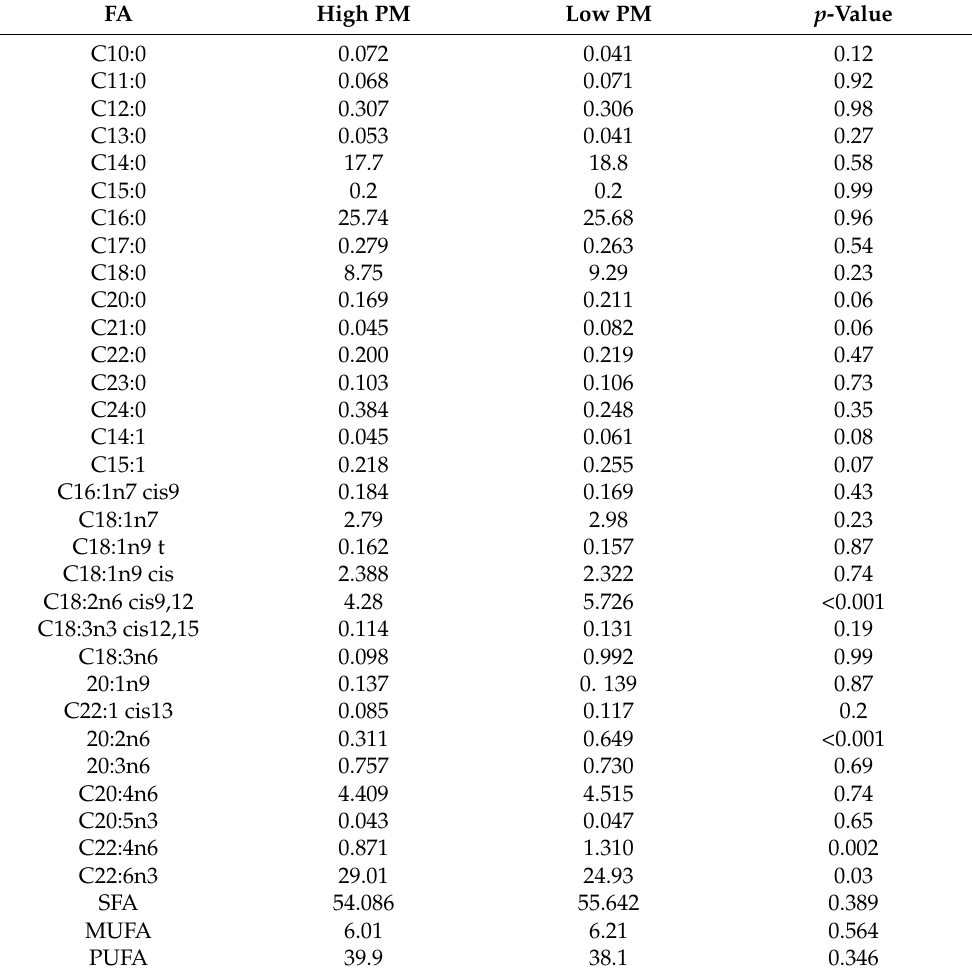
Table 1. Fatty acid (FA) composition of fresh ejaculates with high progressive motility (high-PM; n = 9; >74.0%) and low progressive motility (low-PM; n = 6; <62.5%). Values are relative concentrations out of total fatty acids (mol